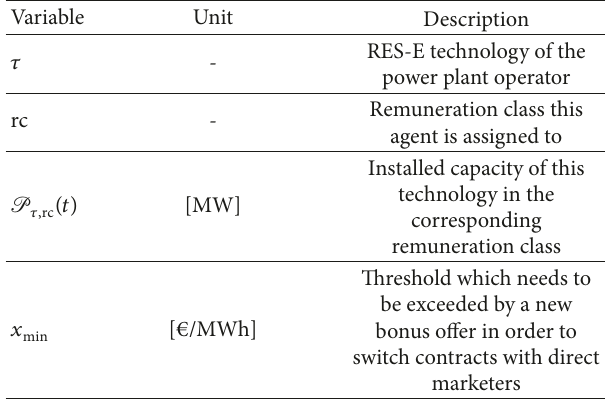
Table 4: Variables that characterize the type of renewable power plant